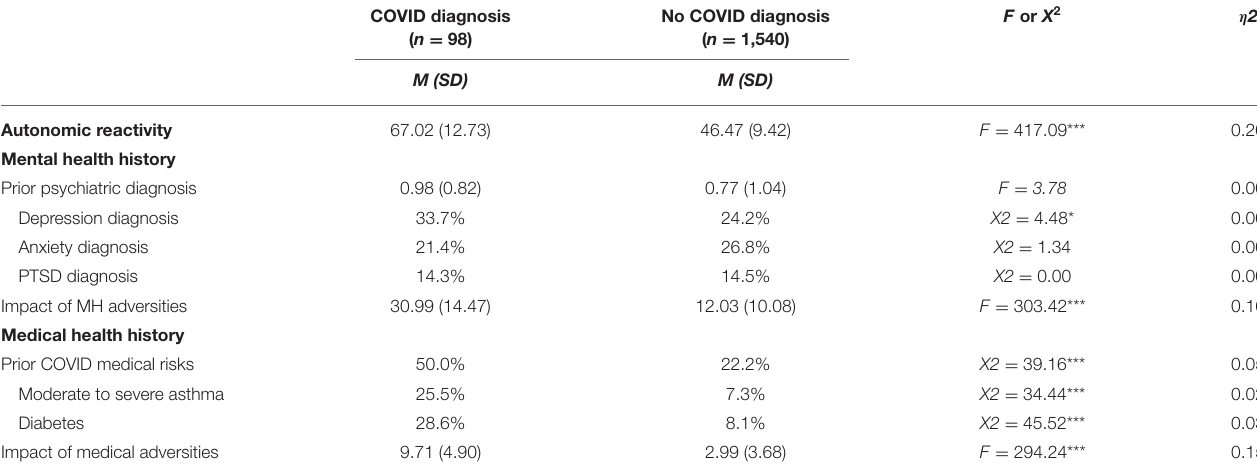
TABLE 1 | Vulnerability factors by COVID diagnosis